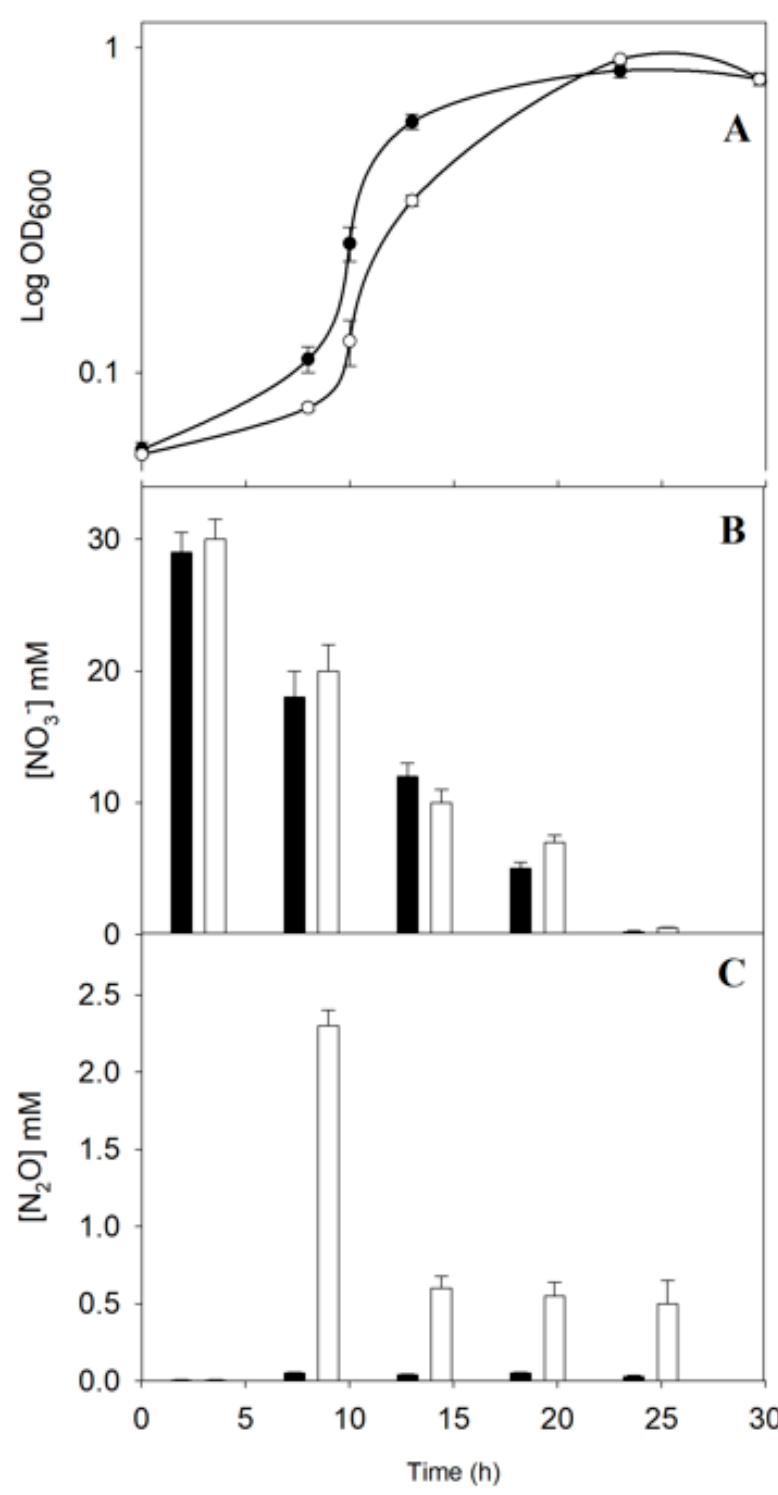
Figure 1. Physiological characterization of the P. denitrificans NtrY mutant under denitrifying conditions. The P. denitrificans wild-type strain (black) and NtrY mutant (white) were grown in minimal media with 30 mM nitrate as the sole nitrogen and energy source under anaerobic conditions. ( A ) Growth was determined by measuring the optical density at 600 nm. ( B ) Nitrate concentration in the media and ( C ) nitrous oxide production were determined as described in Materials and Methods section. Error bars correspond to data from three independent replicates (n = 3).